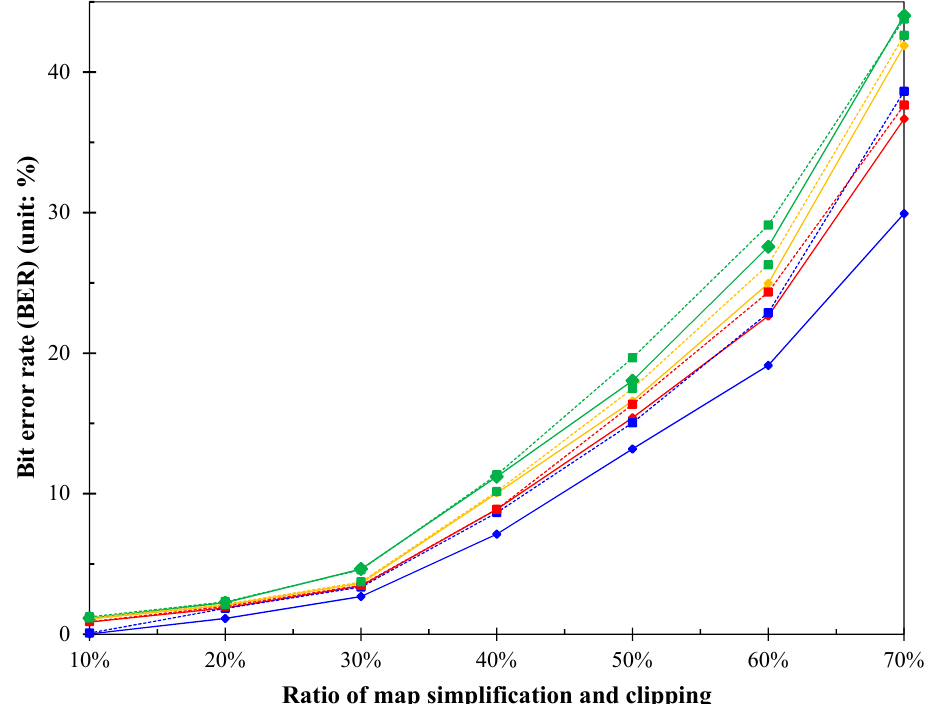
Figure 14. Comparison results of watermark extraction after map simplification and clipping. The blue solid line, the red solid line, the green solid line and the yellow solid line denote the BER of this scheme, the BER of the scheme in [5], the BER of the scheme in [6] and the BER of the scheme in [13] after map simplification, respectively. The blue dashed line, the red dashed line, the green dashed line and the yellow dashed line denote the BER of this scheme, the BER of the scheme in [5], the BER of the scheme in [6] and the BER of the scheme in [13] after map clipping, respectively.